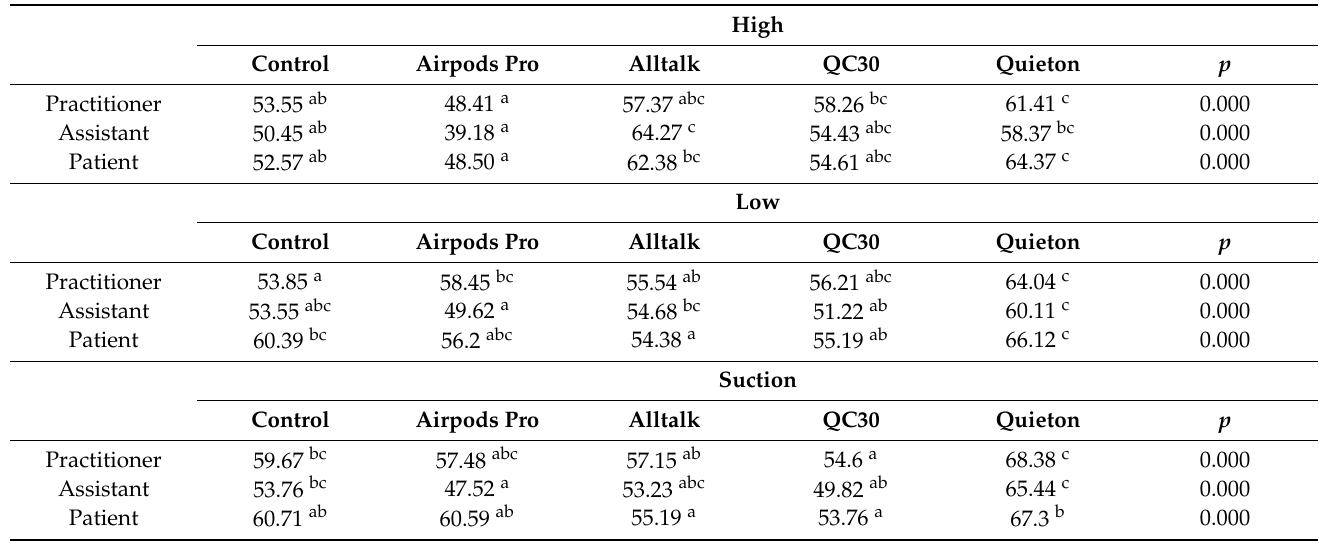
Table 2. Mean value of maximum sound pressure level (during tooth